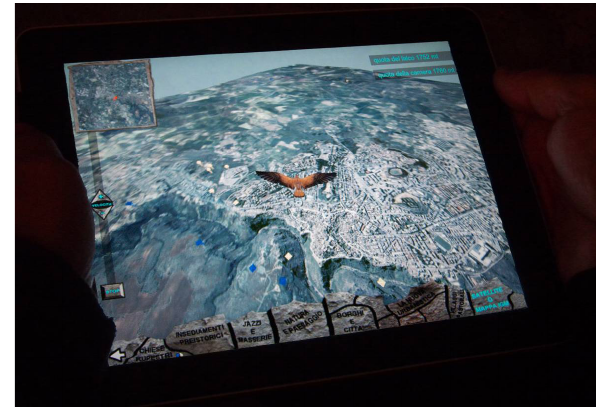
Figure 2. Ipad application: real time exploration of the territory In fact the rupestrian civilization is not only referred to the central historical neighbourhoods of the town but also to the territory of the Rupestrian Churches Park all around, including thousands of prehistorical, neolithic, medieval sites (Fonseca, 1978). The 3D reconstruction of the context is based on a GIS project, where all the data are geo-referred and integrated. The DEM was generated from topographical surveys with different resolutions: 1:10.000, 1:2.000, 1:500 (thanks to Ufficio Sassi of Matera) and its final resolution is 2 mt, to be managed with many LODs (level of details) because for the real time visualization in iPad we need to limit the calculation to 20- 25.000 polygons. The 3D geometry, divided in many tiles according to the level of detail adopted, was mapped with Quickbird satellite photos (80 cm resolution), and with an IGM map where it is easier lo locate and identify all the topographical themes. The virtual exploration is controlled by a very particular third person camera: moving and tiping the iPad altitude and speed, turn left and right acting the